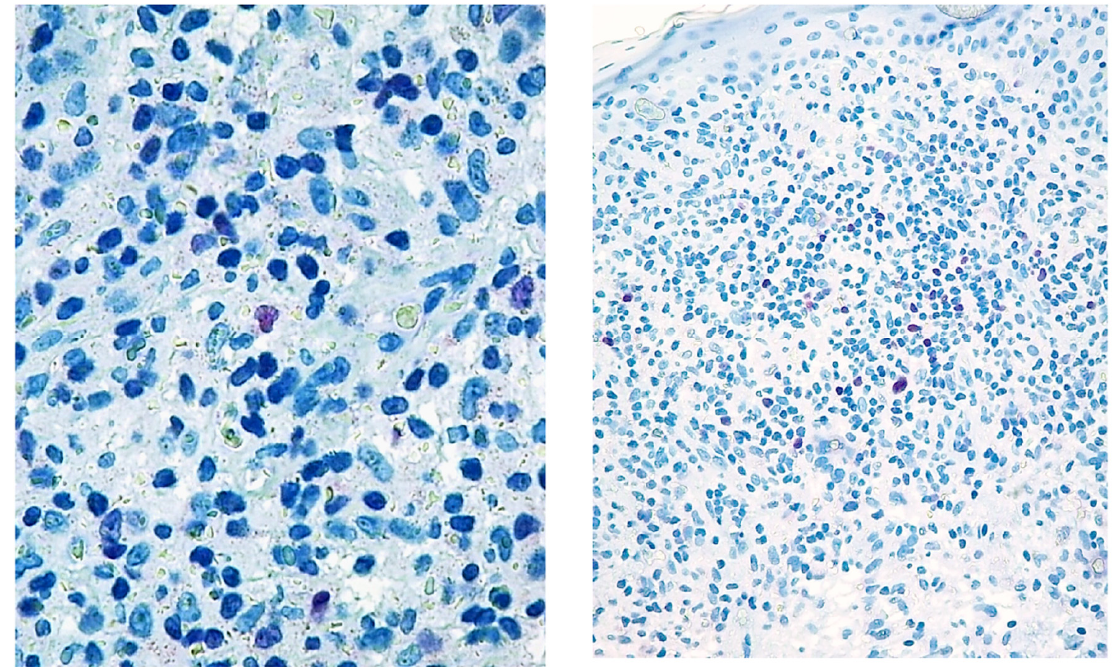
Figure 1. Paradigmatic example of score 1 of Tox expression in two cases.